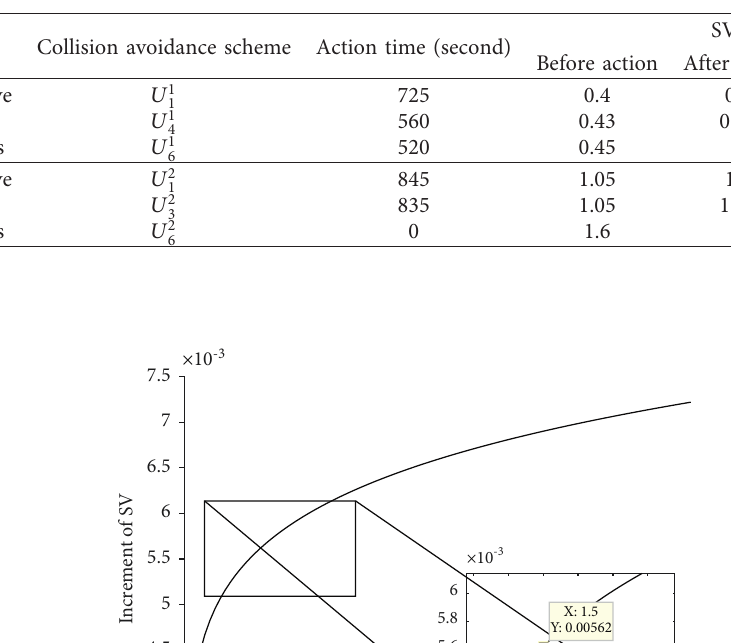
Figure 12: Results of decision indicators with cautious officers in (a) scenario I and (b) scenario II. Table 5: Results under different